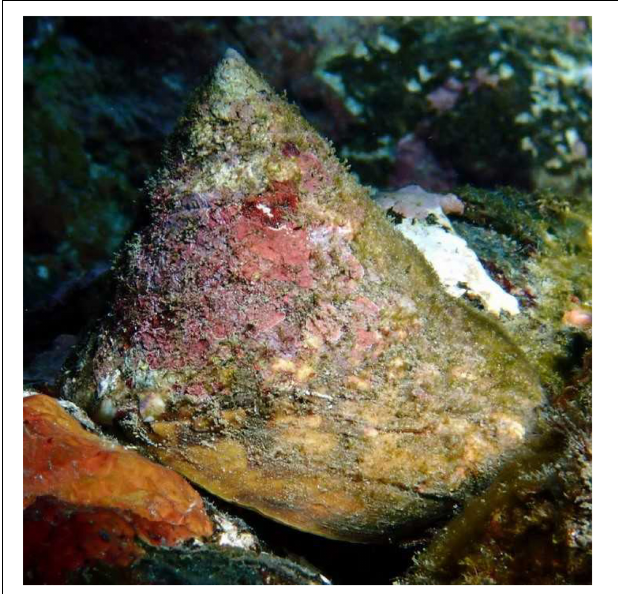
FIGURE 1 | Rochia nilotica on the reef in Samoa (illustrated specimen ∼ 90 mm BSW) (Photo: Steven Purcell).